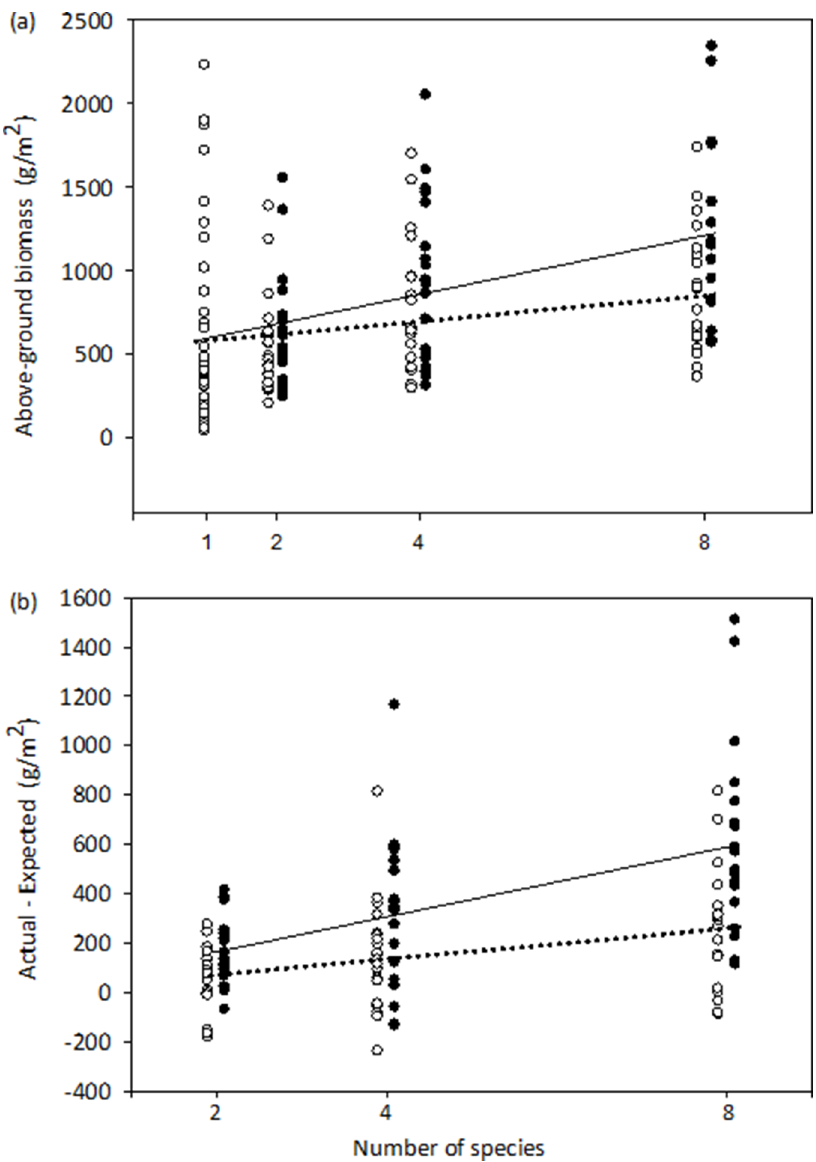
Figure 3. Overyielding and the magnitude of complementary effects. ( a ) Linear relationships between aboveground biomass and species richness for aggregated (dashed lines and open circles) and dispersed mixtures (solid lines and filled circles) of experiment II. ( b ) Difference in aboveground biomass between the observed mixture plots and the mean monoculture biomass of all species across diversity gradients for experiment II. This difference measures overyielding and the degree of difference indicates the degree of complementarity effects. Dashed lines and open circles refer to plots with aggregated mixtures, and solid lines and filled circles refer to dispersed plots.